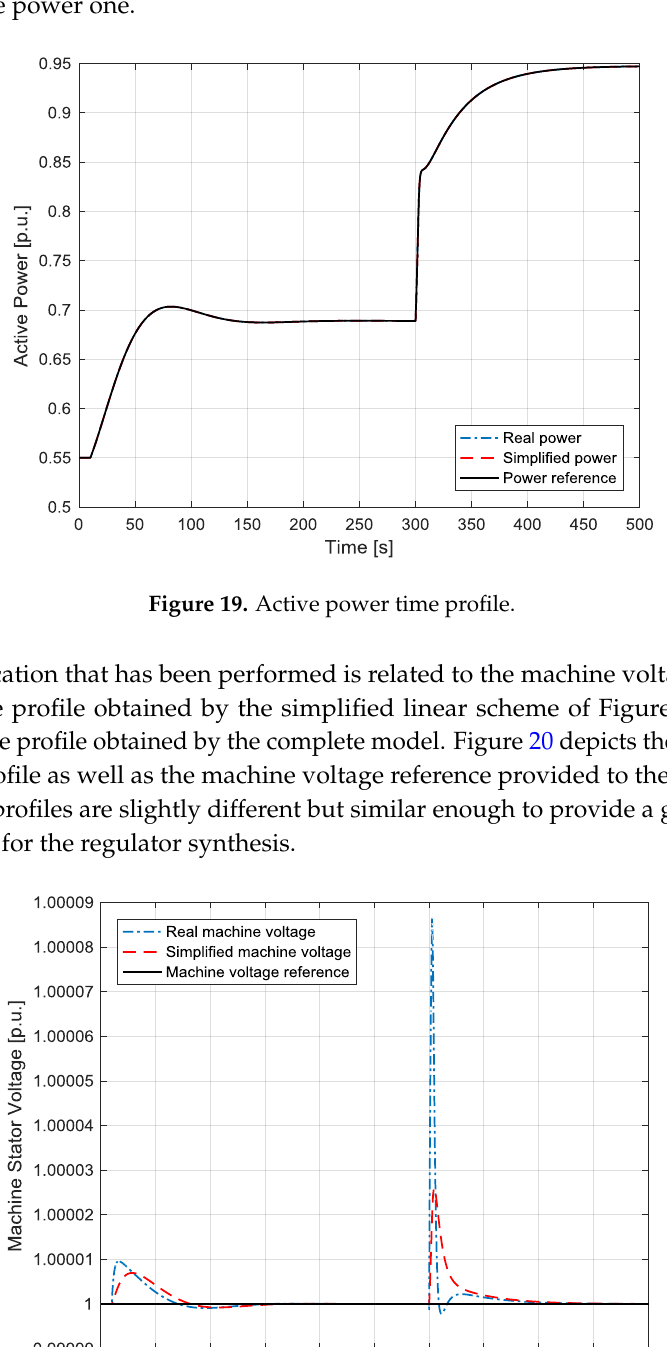
Figure 20. Machine voltage time profile.